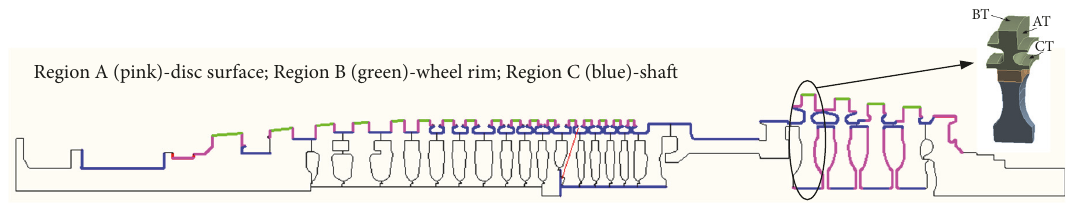
Figure 4: Schematic diagram of the thermal boundary